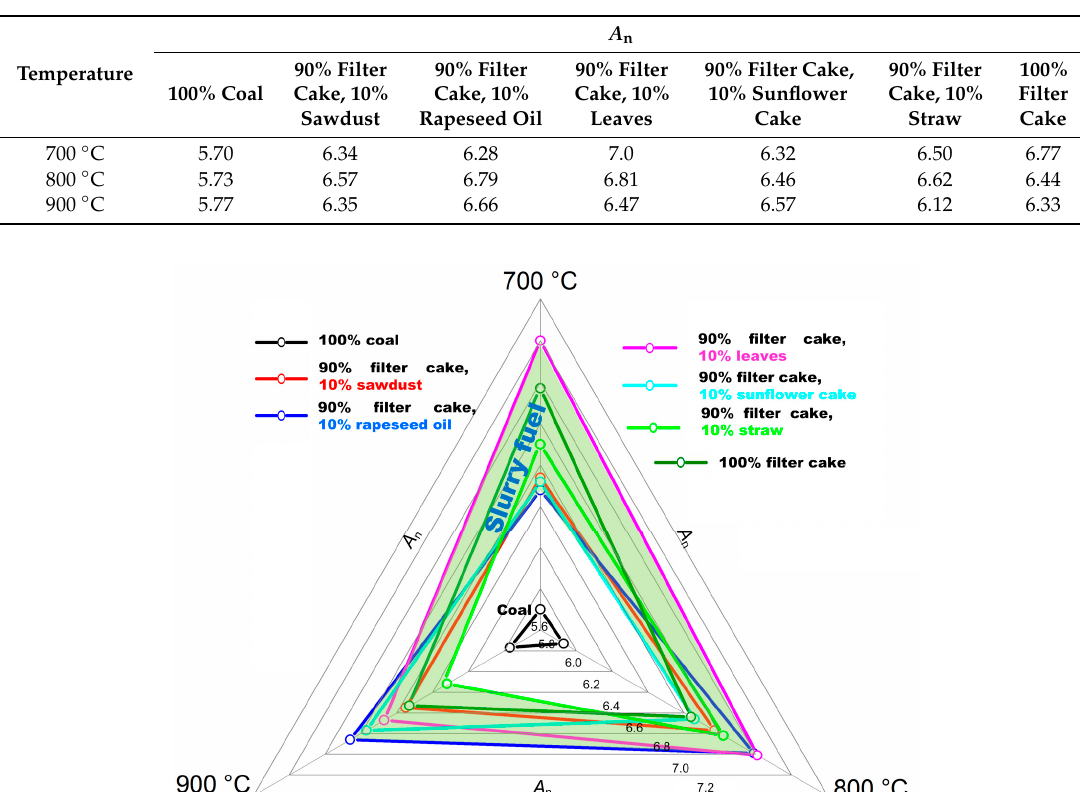
Table 6. Resulting efficiency indicators calculated according WSM.